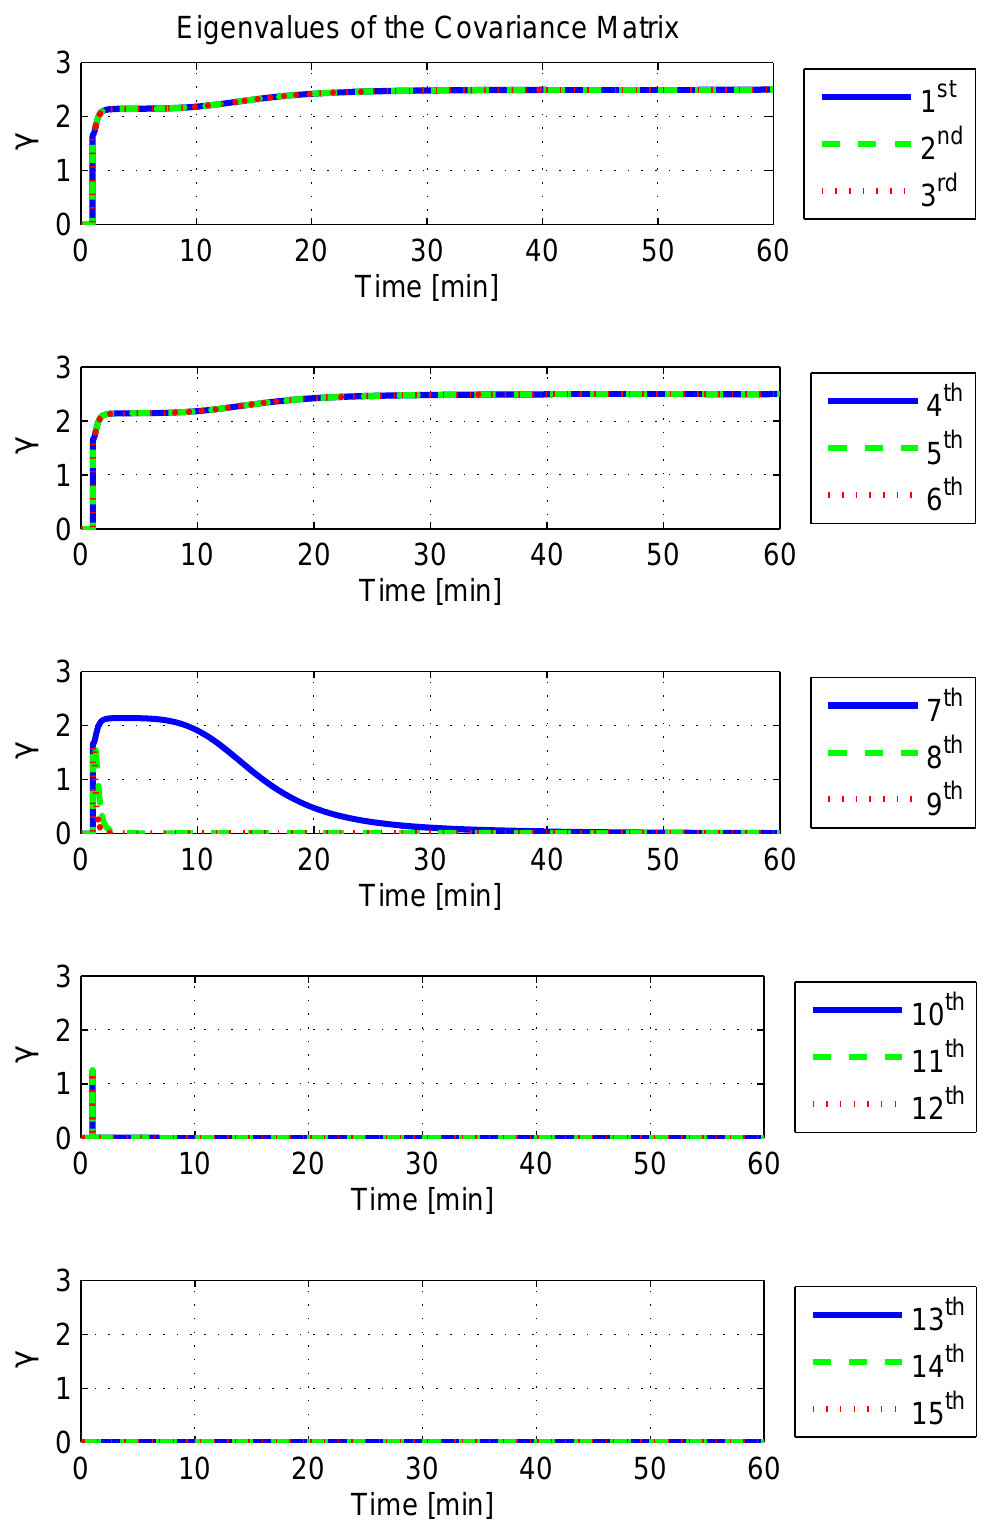
Figure 7. Eigenvalues of the covariance matrix in simulated